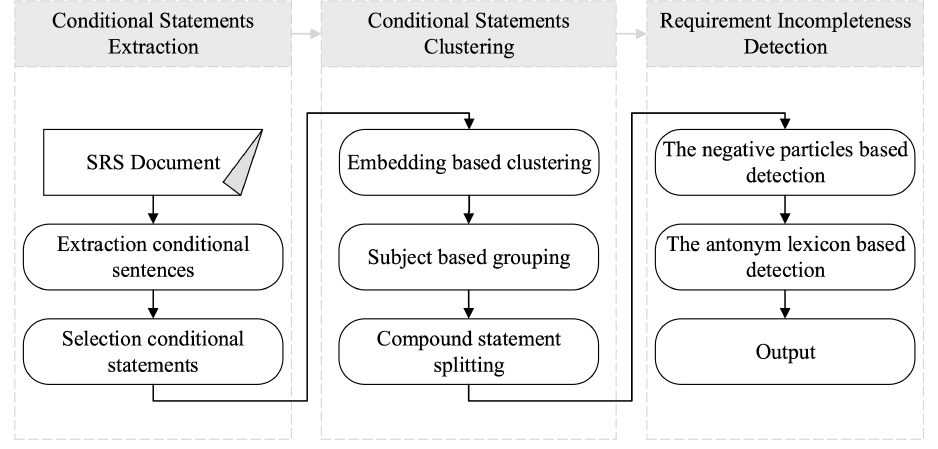
Figure 1. The framework of the proposed